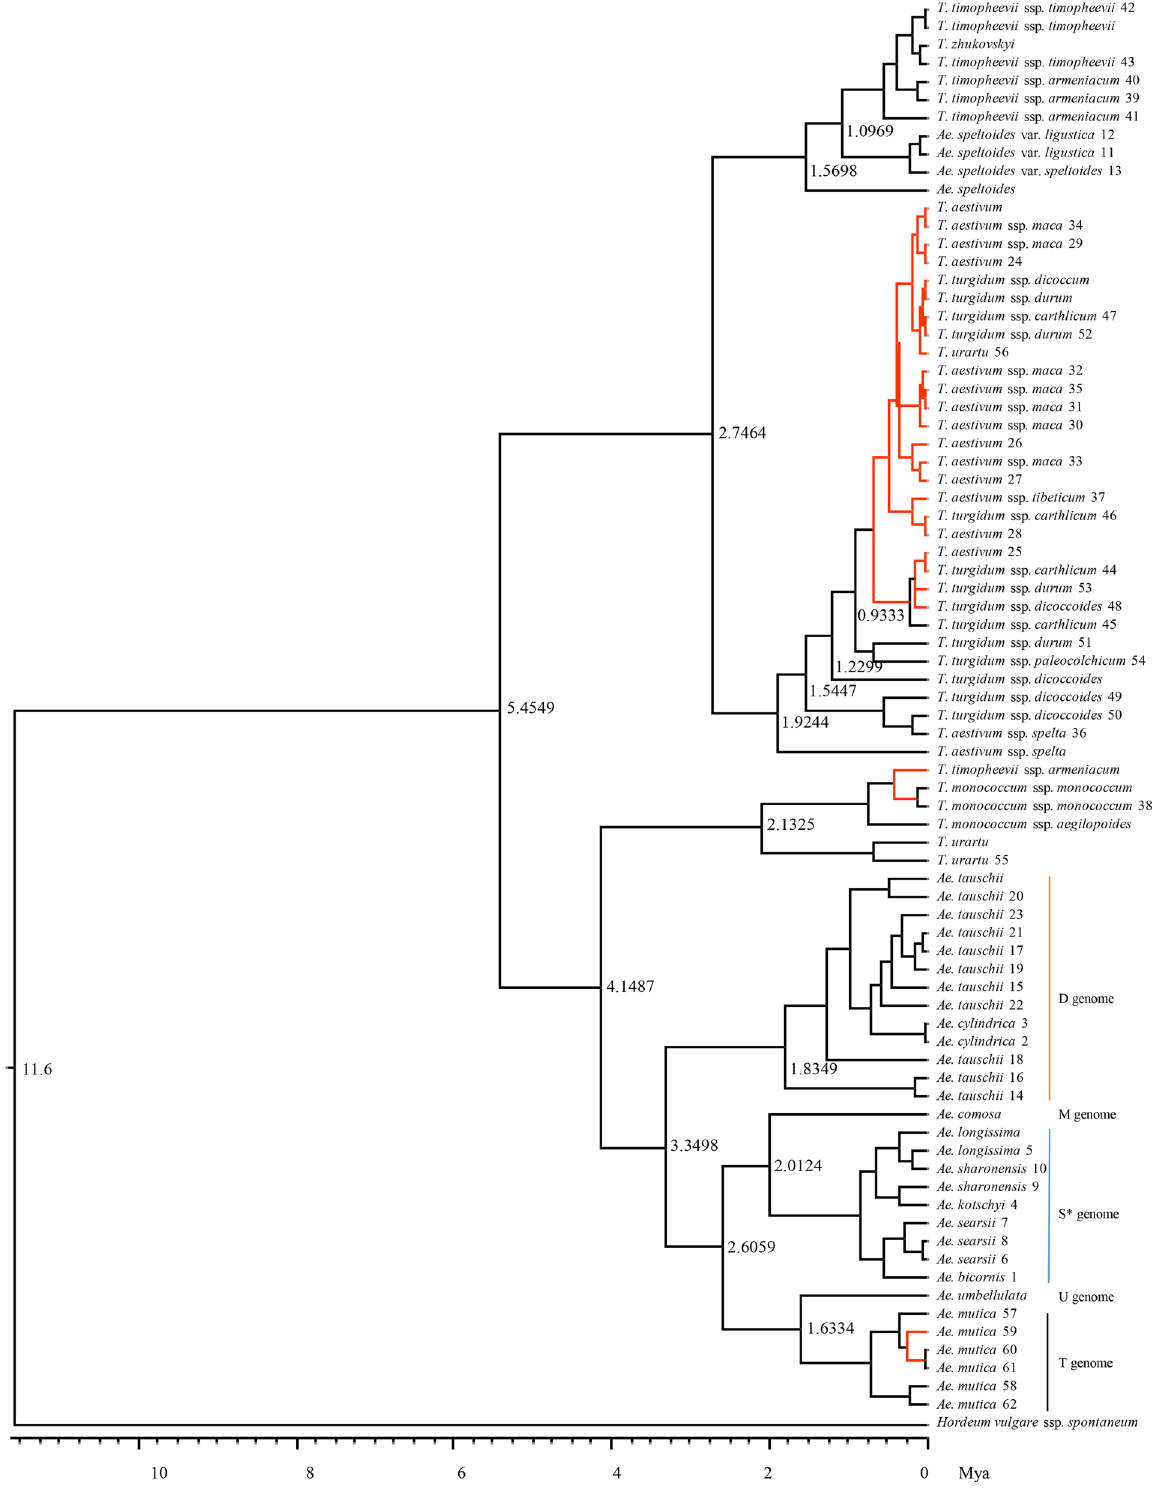
Figure 4. Bayesian maximum clade credibility trees of published 72 complete and six incomplete chloroplast genomes representing six Triticum and 11 Aegilops species with nodal support (in posterior probability) and outgroup of Hordeum vulgare ssp. spontaneum , as inferred from chloroplast sequence variations using BEAST software. A sample with a number after its species name was published by others and a sample without the number label was assembled from this study (see Table S1). The nodes with a posterior probability of 0.90 or less are highlighted in red. The node ages were calibrated with the root ages in Mya following the related age estimates by Chalupska et al . 14 . Some lineage ages are shown, along the divergence time axis at the bottom of the